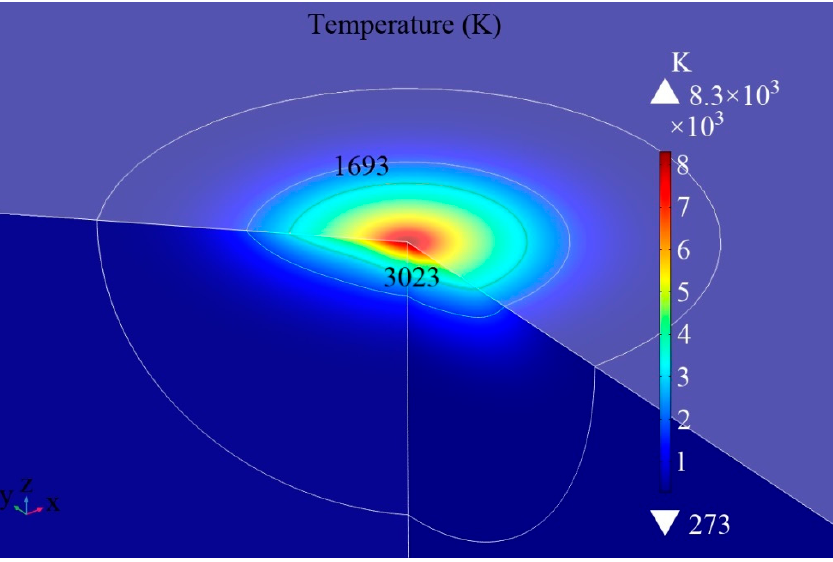
Figure 3. The temperature distribution in micro/nano-EDM considering non-Fourier effect.